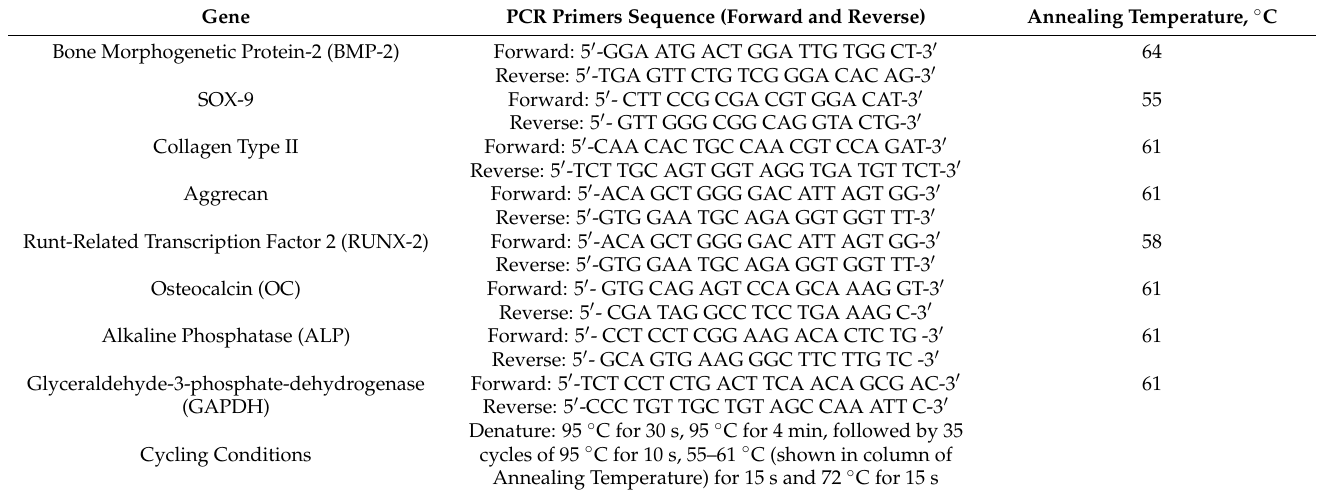
Table 1. Primer sequences and cycling conditions for real-time